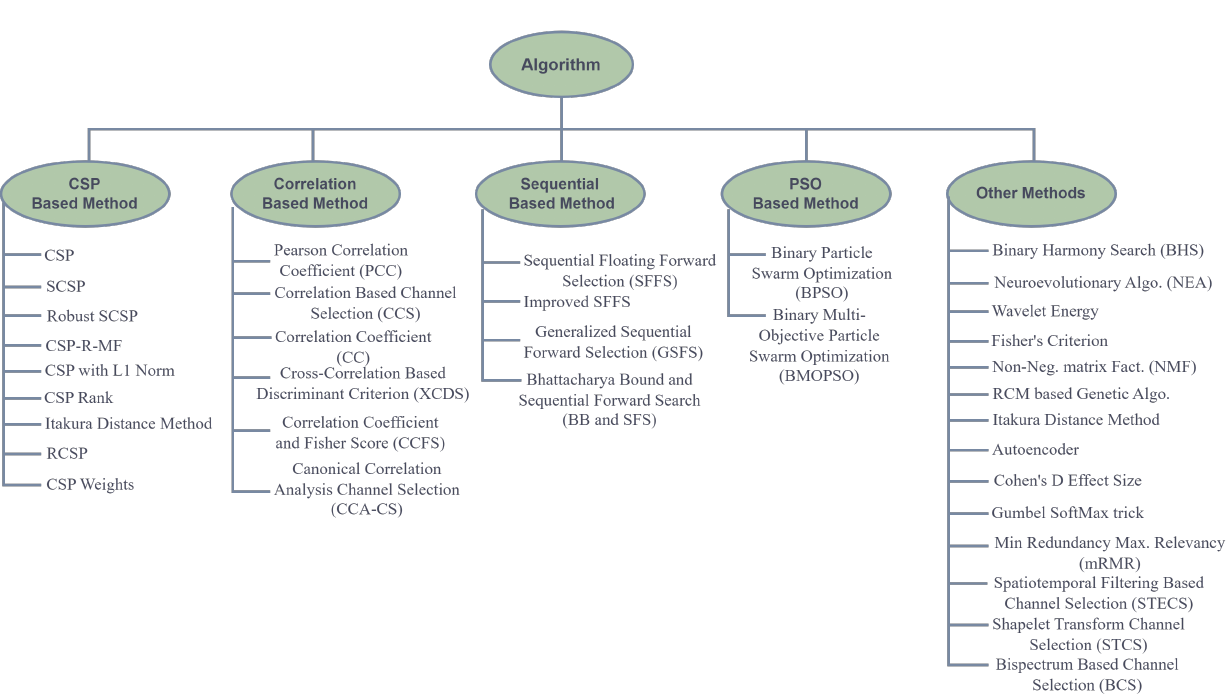
Figure 3. Different EEG channel selection